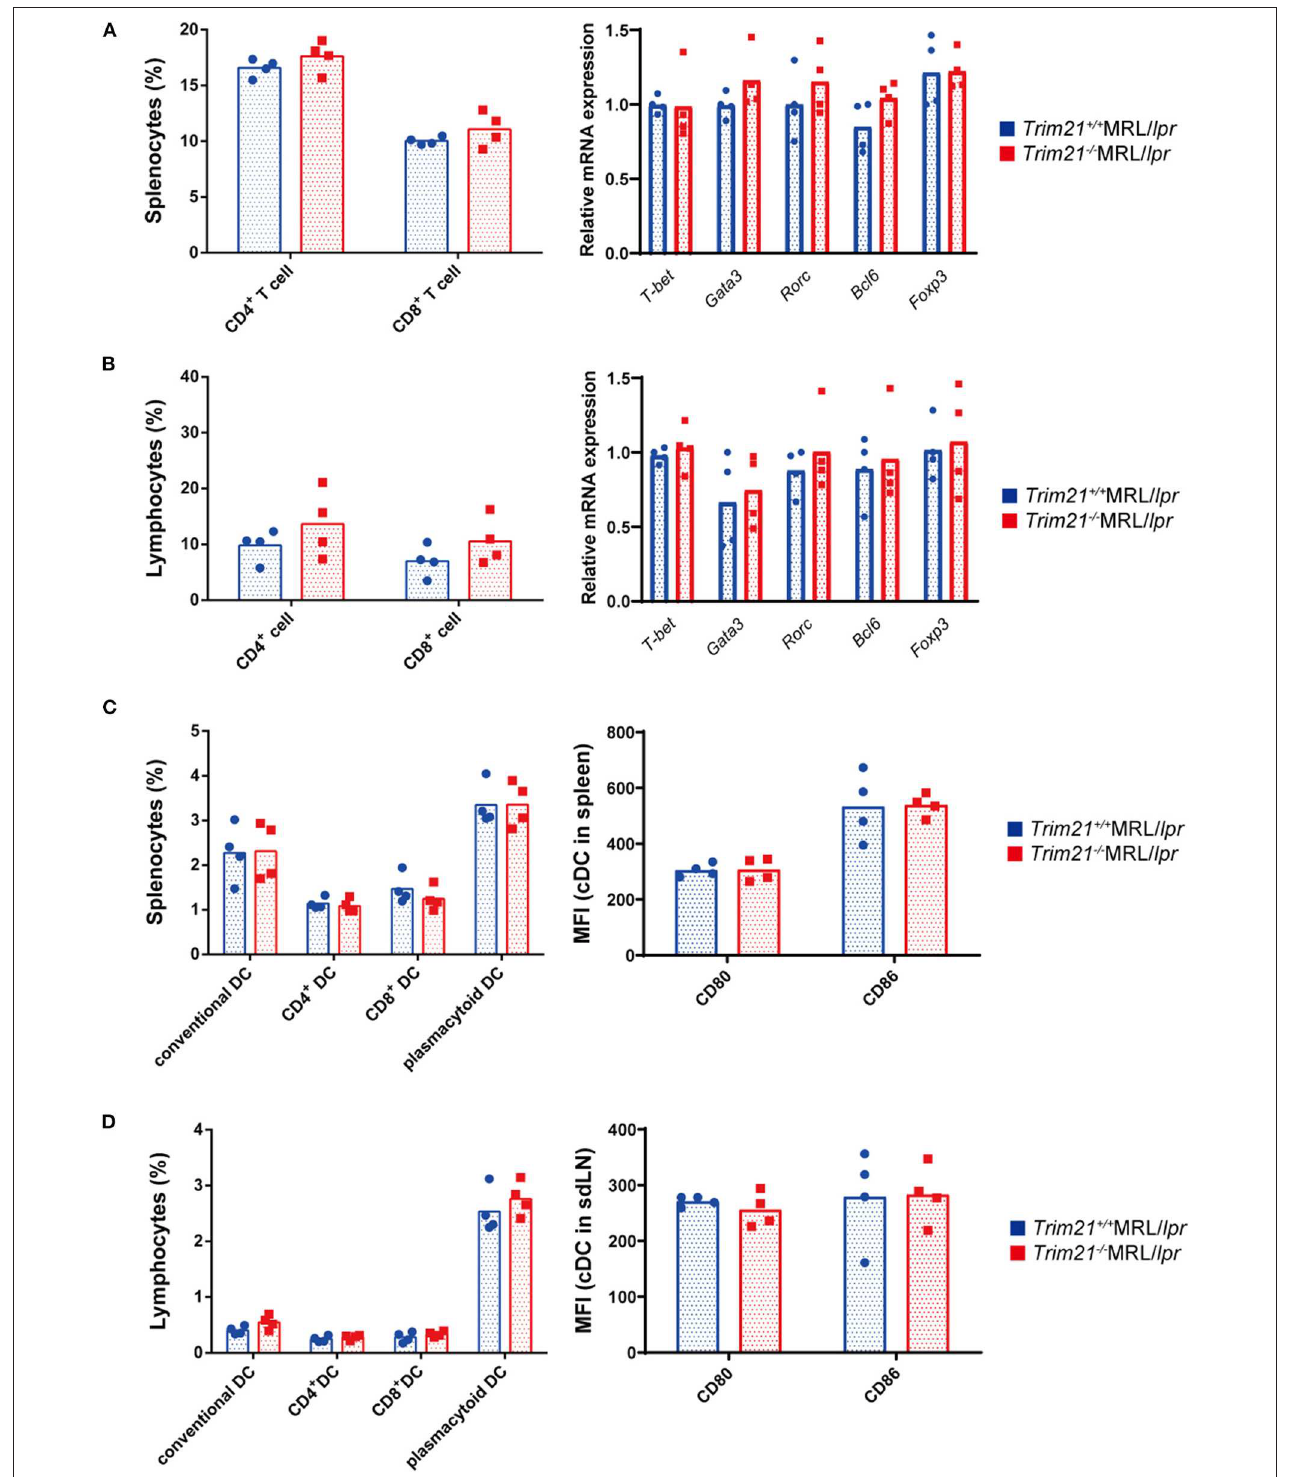
FIGURE 5 | The comparison of T cell and DC subset populations between Trim21 + / + MRL/ lpr mice and Trim21 − / − MRL/ lpr mice. Flow cytometric analyses and qPCR analyses were performed for sdLN cells at 10 weeks of age ( n = 4 in each group). (A,B) T-cell subsets in spleen and sdLNs were classified by surface markers as follows: CD4 + T cell; CD3 + CD4 + and CD8 + T cell; CD3 + CD8 + . mRNA expression levels of various T cell transcription factors in CD3 + T cells from spleens and sdLNs were measured by qPCR. (C,D) DC subsets in spleen and sdLNs were classified by surface markers as follows: cDC, I-Ab + B220 − CD11c + ; CD4 + DC, CD3 − CD4 + CD11c + ; CD8 + DC, CD3 − CD8 + CD11c + ; and pDC, CD317 + B220 + SiglecH + . MFIs of CD80 and CD86 were measured in cDCs.